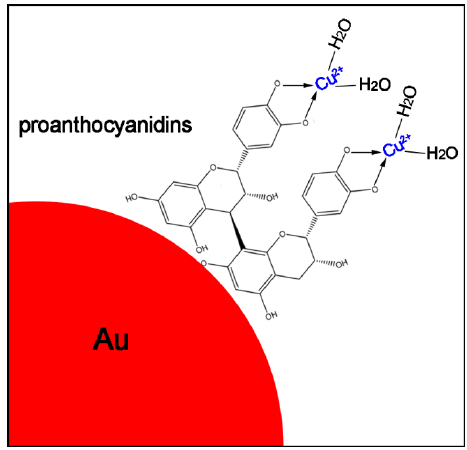
Figure 8. Schematic illustration of the interaction process between proanthocyanidin-functionalized gold nanoparticles and heavy metal ions (Example for Cu 2+ ).